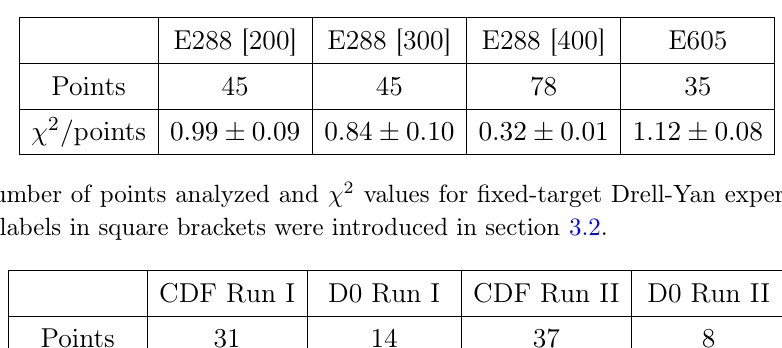
Figure 7 . Drell-Yan differential cross section for different experiments and different values of p s and for different Q bins. For clarity, each Q bin has been normalized (the first data point has h i h i been set always equal to 1) and then shifted by an offset indicated in the legend.